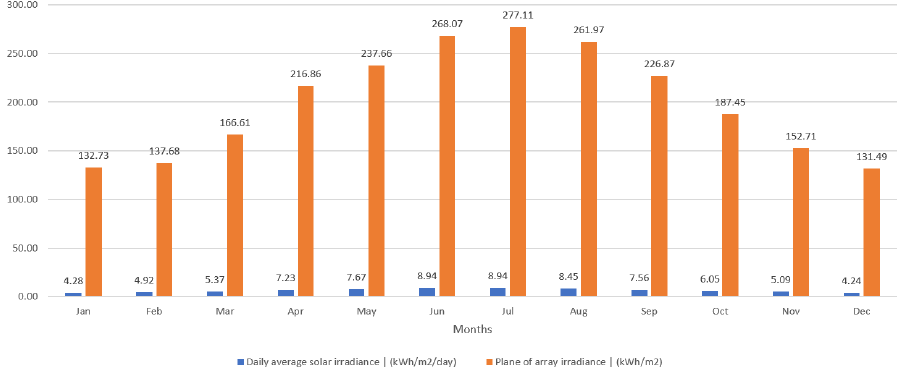
Figure 10. Graph of monthly average solar irradiance and array irradiance in kWh/m 2 for Smithland, KY 2021 [27].